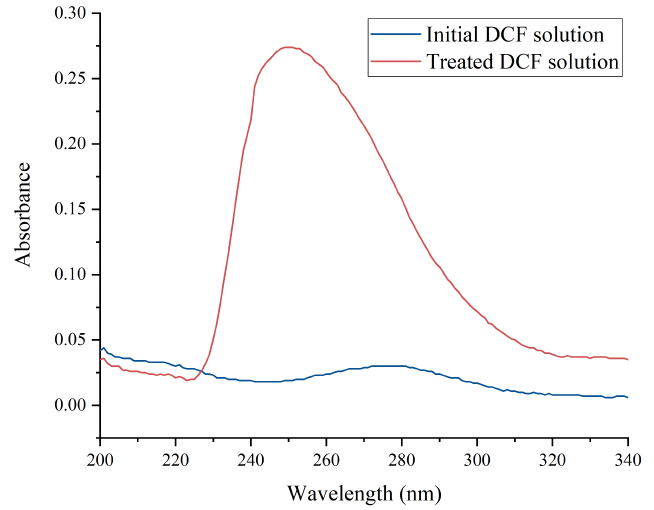
Figure 9. Change of the maximal peak wavelength in the UV spectrum as a result of